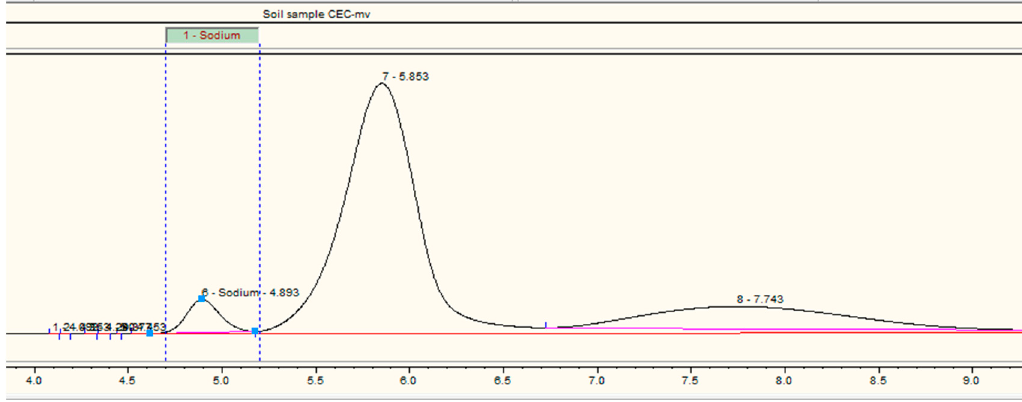
Figure 1. Ion chromatography peaks showing clearly separated sodium and ammonium.